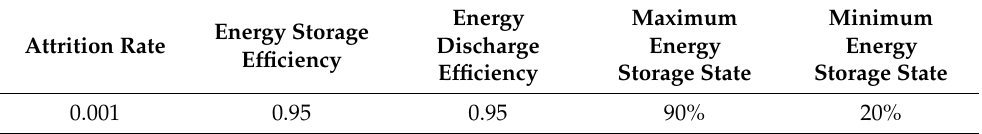
Table A2. Parameters of energy storage devices.